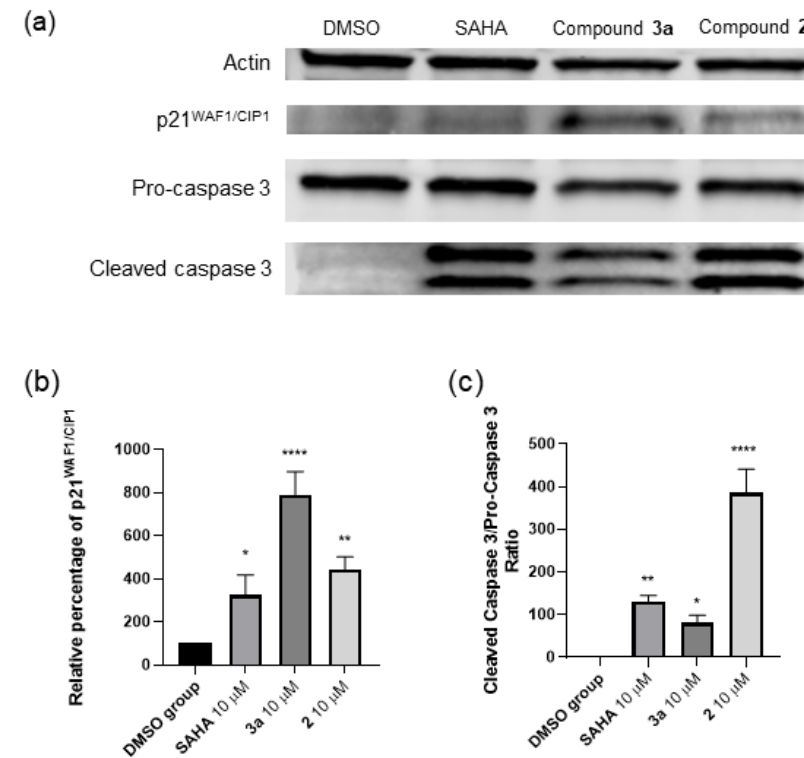
Figure 6. Compounds 2 and 3a induced apoptosis in the Hep-G2 cell line via p21 WAF1 / CIP1 expression and caspase 3 activation. ( a ) The immunoblot of Actin, p21 WAF1 / CIP1 , pro-caspase 3, and cleaved caspase 3 in the Hep-G2 cell line treated with 0.1% DMSO or 0.1% DMSO solution of SAHA (10 µ M), 3a (10 µ M) and 2 (10 µ M) for 24 h. Quantification of immunoblot obtained for p21 WAF1 / CIP1 ( b ) and caspase ( c ), averaging data from three independent experiments. (Bars show mean plus standard deviation; * p < 0.05; ** p < 0.0021; **** p < 0.0002).